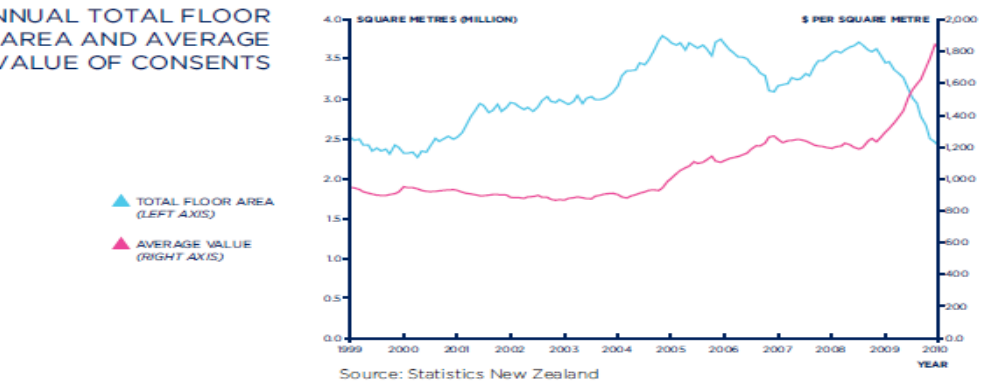
Figure 136: Annual Total Floor Area and Average Value of